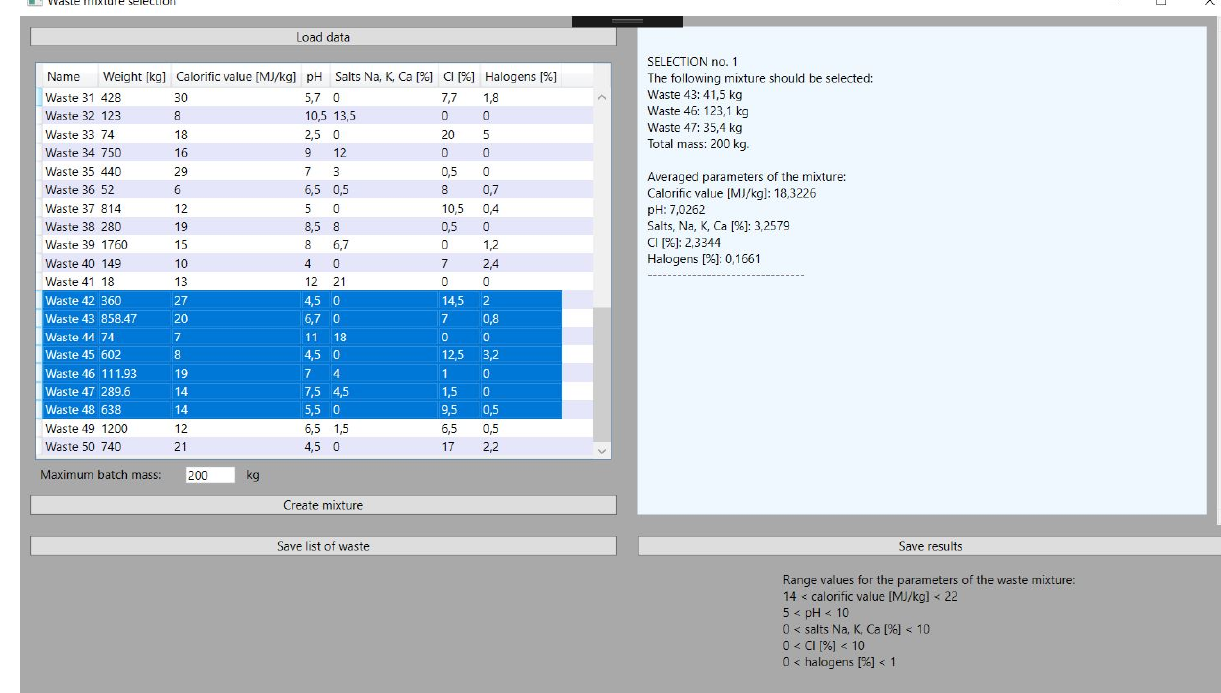
Figure 6. Selection of types of waste to the input waste material mixture.